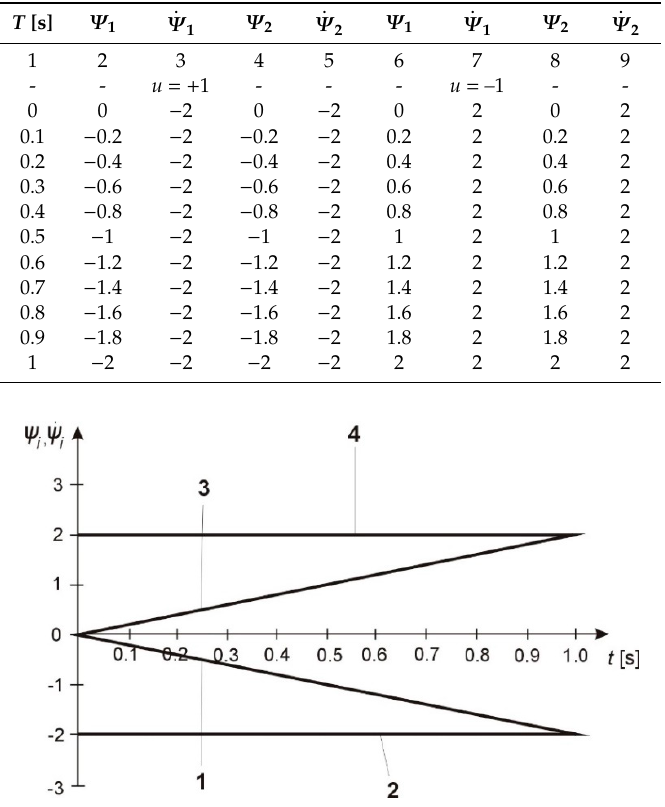
. . ψ ψ , for u ( t ) = − 1; 3 − ψ 1 , ψ 2 , 1 2